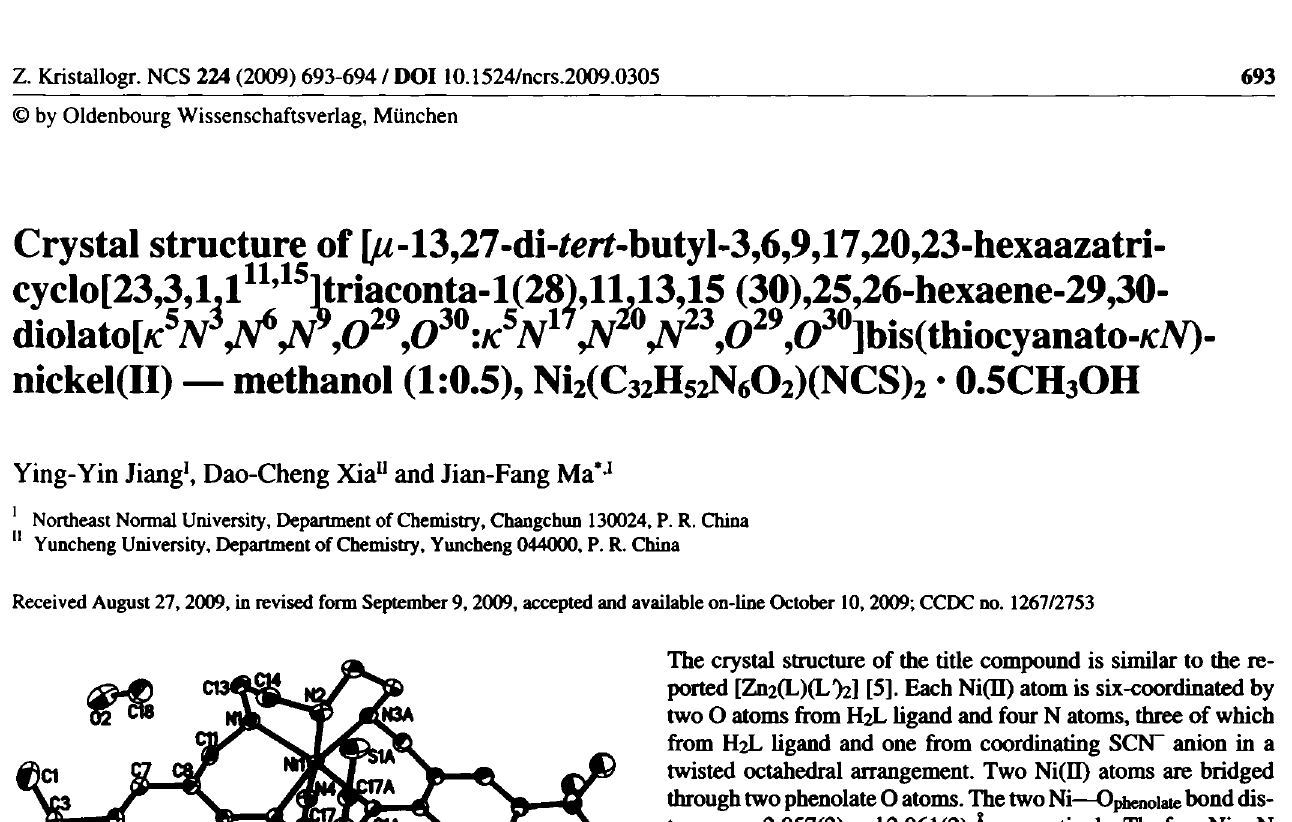
Table 2. Atomic coordinates and displacement parameters (in Â 2